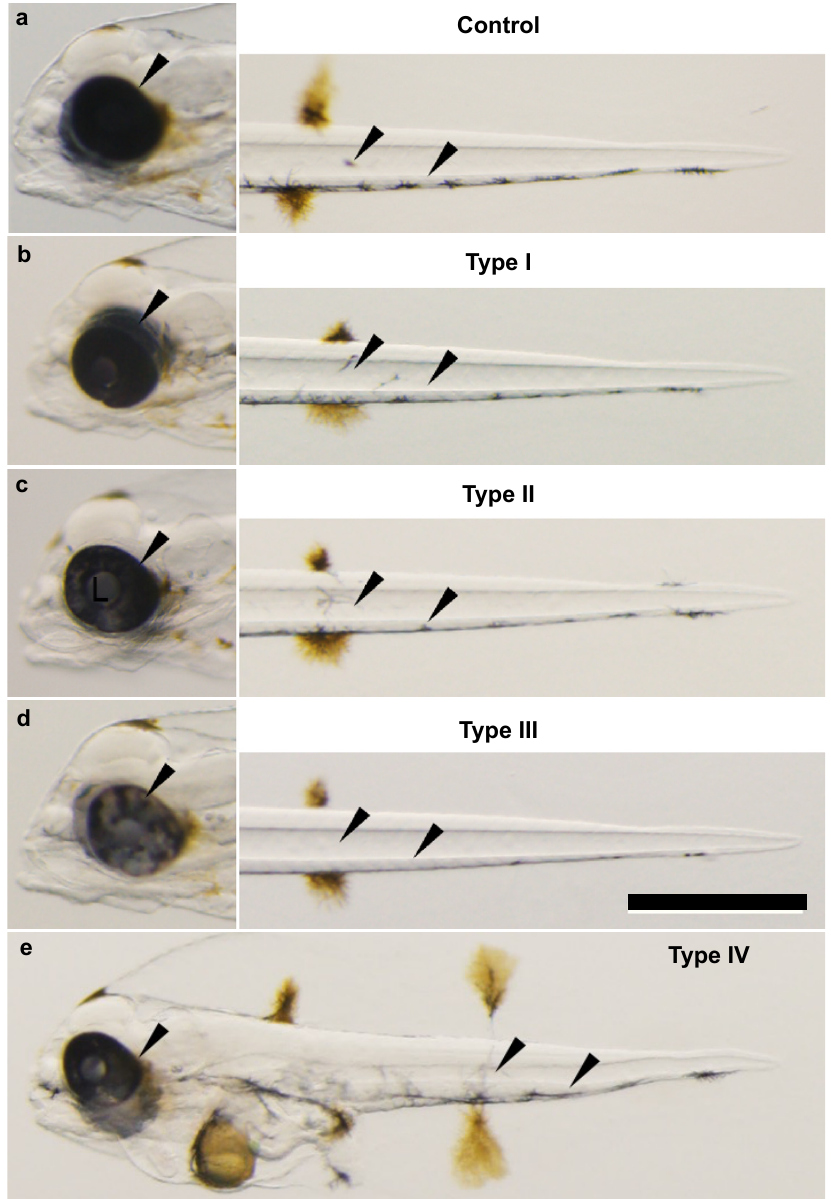
Figure 5. Phenotypic classification of pigment patterns in the slc24a5 mutant at 72 hpf. ( a ) Melanin pigmentation in a control larva; ( b ) Type I: mutant with normal body development and pigmentation pattern similar to control, but is genotypically different; ( c ) Type II: mutant with normal body development, with moderate phenotype (mosaic eye); ( d ) Type III: mutant with severe phenotype (mosaic eye, low level of body pigmentation) with normal growth; and ( e ) Type IV: mutant having abnormal body development (short and twisted body, comparatively large head, among other abnormalities). Scale: 1 mm.